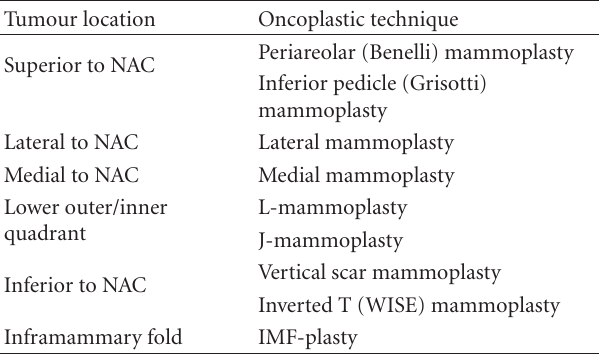
Table 2: Oncoplastic techniques suitable for excision of lesions in specified